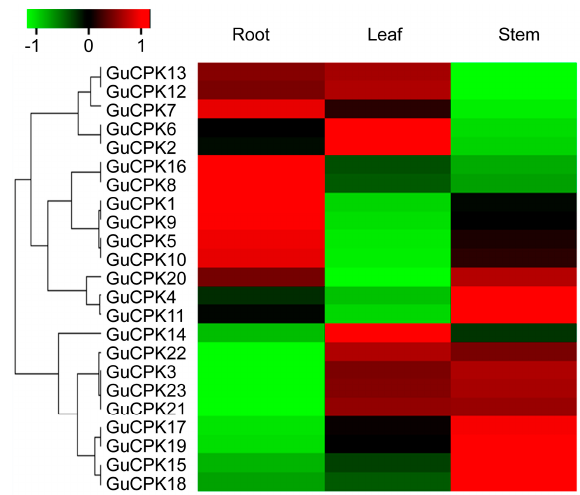
Figure 7. Heatmap of expression levels of G. uralensis GuCPKs in di ff erent tissues. The expression levels of GuCPKs were determined by qRT-PCR. The GuCPK genes were ordered by the cluster of their expression patterns. Each value denotes the mean relative level of expression of three replicates. Higher or lower expressions of GuCPK genes in di ff erent tissues were colored by red or green, respectively. The color bar is shown in the upper apex. The visualized heatmap was generated using R package based on the qRT-PCR data. Molecules 2019 , 24 , x FOR PEER REVIEW